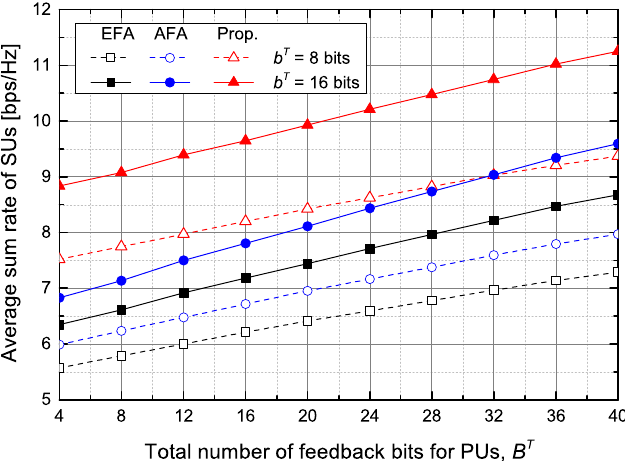
Figure 4. The average sum rate of SUs versus the total number of feedback bits for PUs.